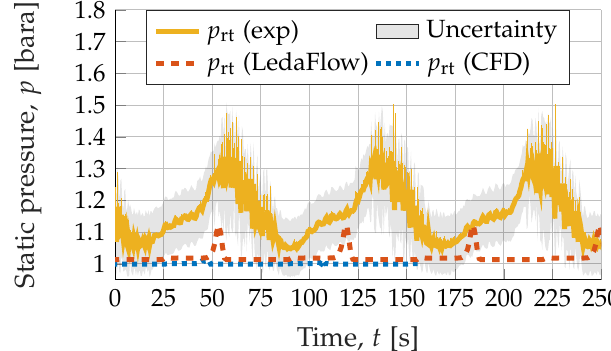
Figure 9. Comparison of CFD, LedaFlow and experimental results for the topside